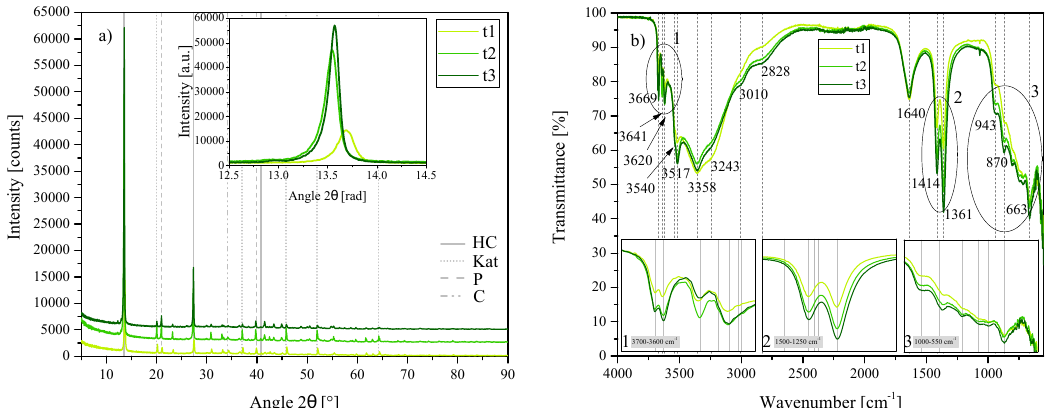
Figure 8. ( a ) XRD results of the time series t1, t2 and t3 between 5 ◦ 2 θ and 90 ◦ 2 θ . Each scan is y-shifted by 2500 counts. The inset depicts the primary LDH peaks and change in position. HC = hydrocalumite, Kat = katoite, P = portlandite and C = calcite. ( b ) FTIR-ATR scans of the time series t1, t2 and t3 between 4000cm − 1 and 550cm − 1 . The three insets show the regions: ( 1 ) 3700cm − 1 – 3600cm − 1 , ( 2 ) 1500cm − 1 – 1250cm − 1 , ( 3 ) 1000cm − 1 – 550cm − 1 in detail. Dashed and solid grey lines indicate the maxima of vibrations. t1 = 1h, t2 = 3h and t3 = 6